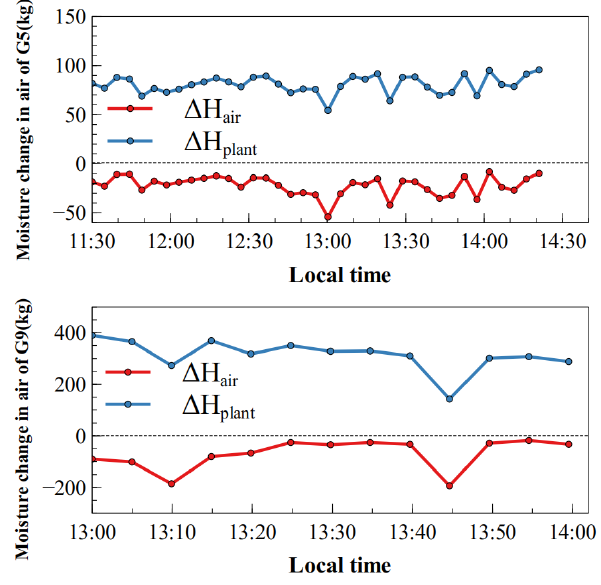
Figure 13. Moisture change in the air of G5 and